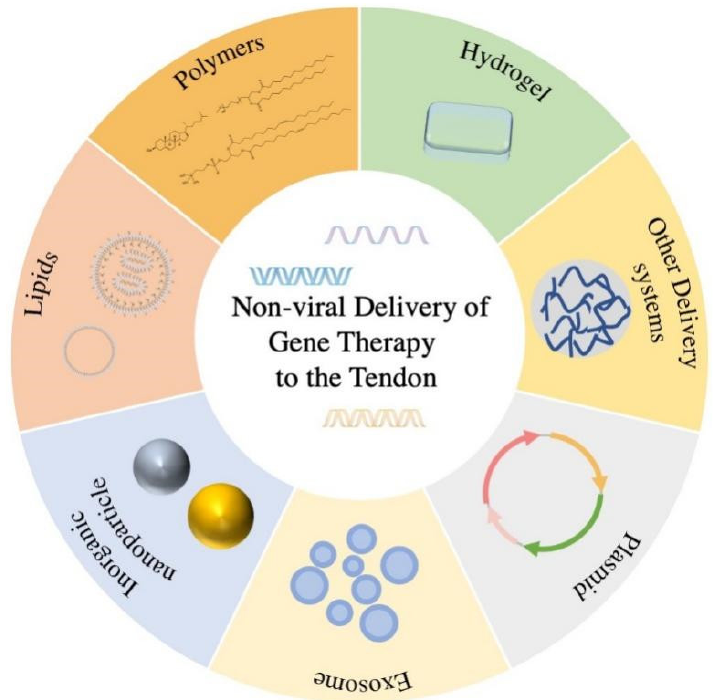
Figure 2. A graphical abstract figure of this review. The non-viral delivery of gene therapy to the tendon consists of plasmids, exosomes, inorganic nanoparticles, lipids, polymers, hydrogels, and other delivery systems.